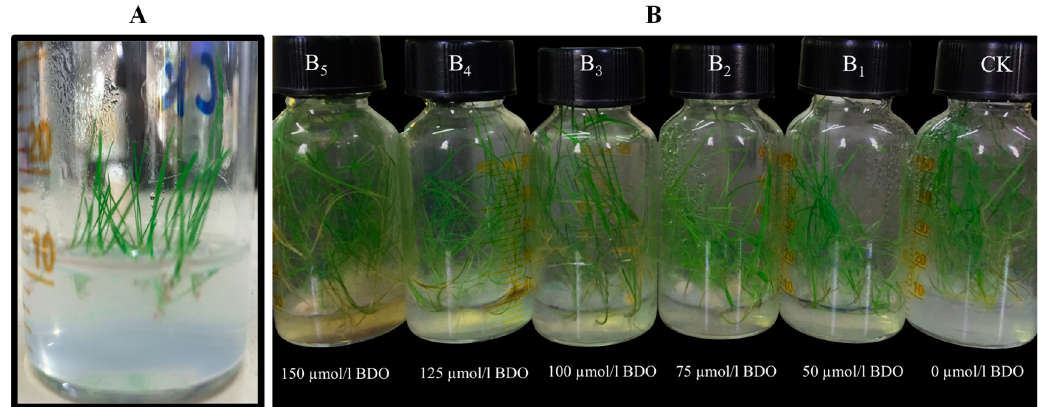
Figure 11. ( A ) About 20 seedlings per vial were grown in 50-mL gas chromatography vials with